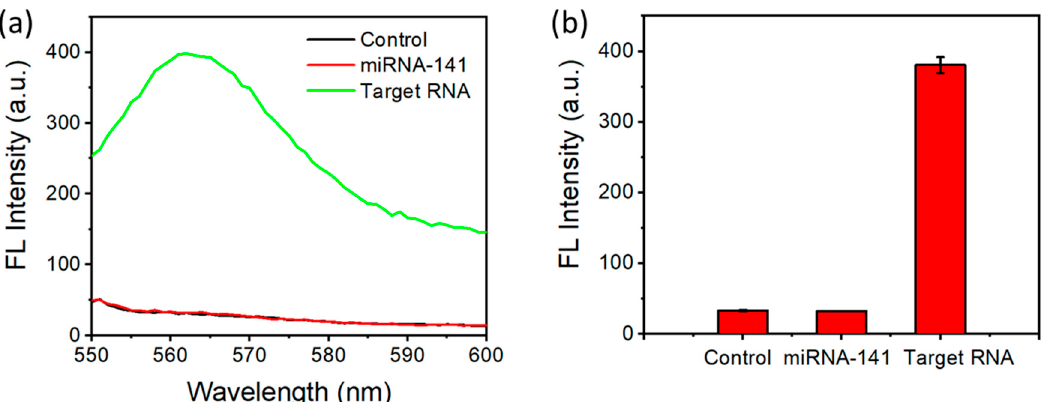
Figure 6. Selectivity of detection. ( a ) Fluorescence emission spectra with different RNA (100 nM). ( b ) The peak fluorescence values with different RNA.